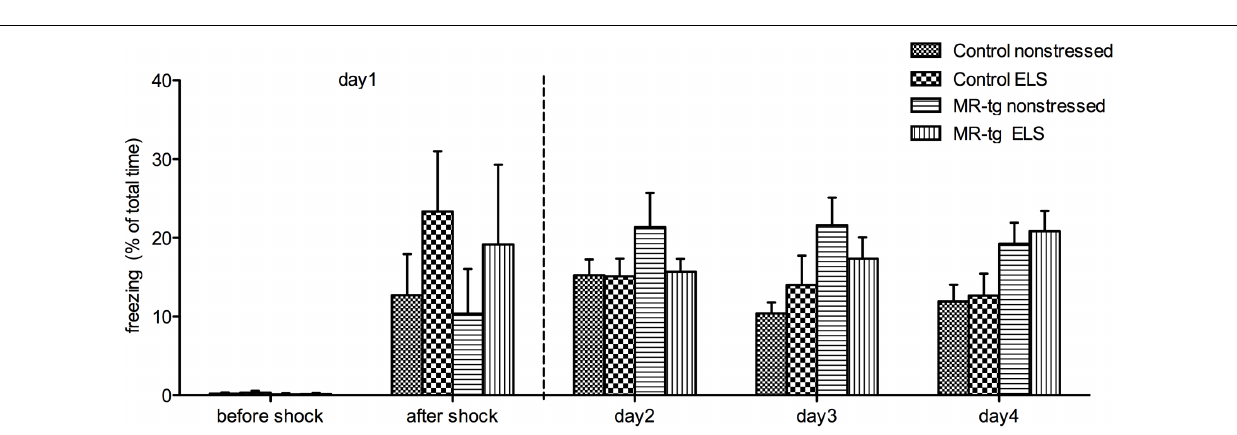
FIGURE 4 | Contextual fear conditioning in MR-tg and control mice. Bar graphs represent freezing time before the foot-shock (day 1), immediately after the foot-shock (day 1), and on day 2, day 3 and day 4. Data are expressed as mean ± SEM with p -values based on post hoc LSD. n = 8–11 mice per